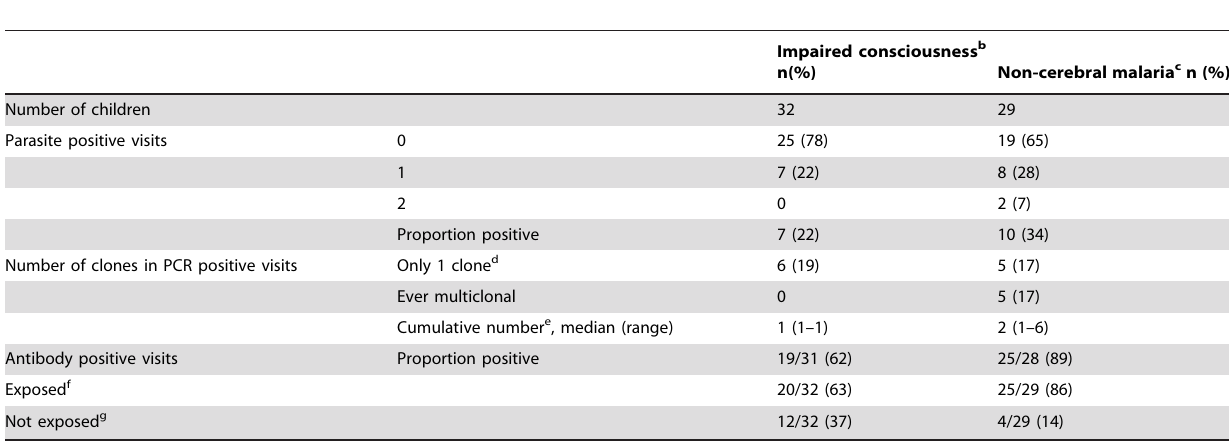
Table 3. Assessment of exposure in three-monthly visits from birth until admission a in 61 children admitted with severe malaria.